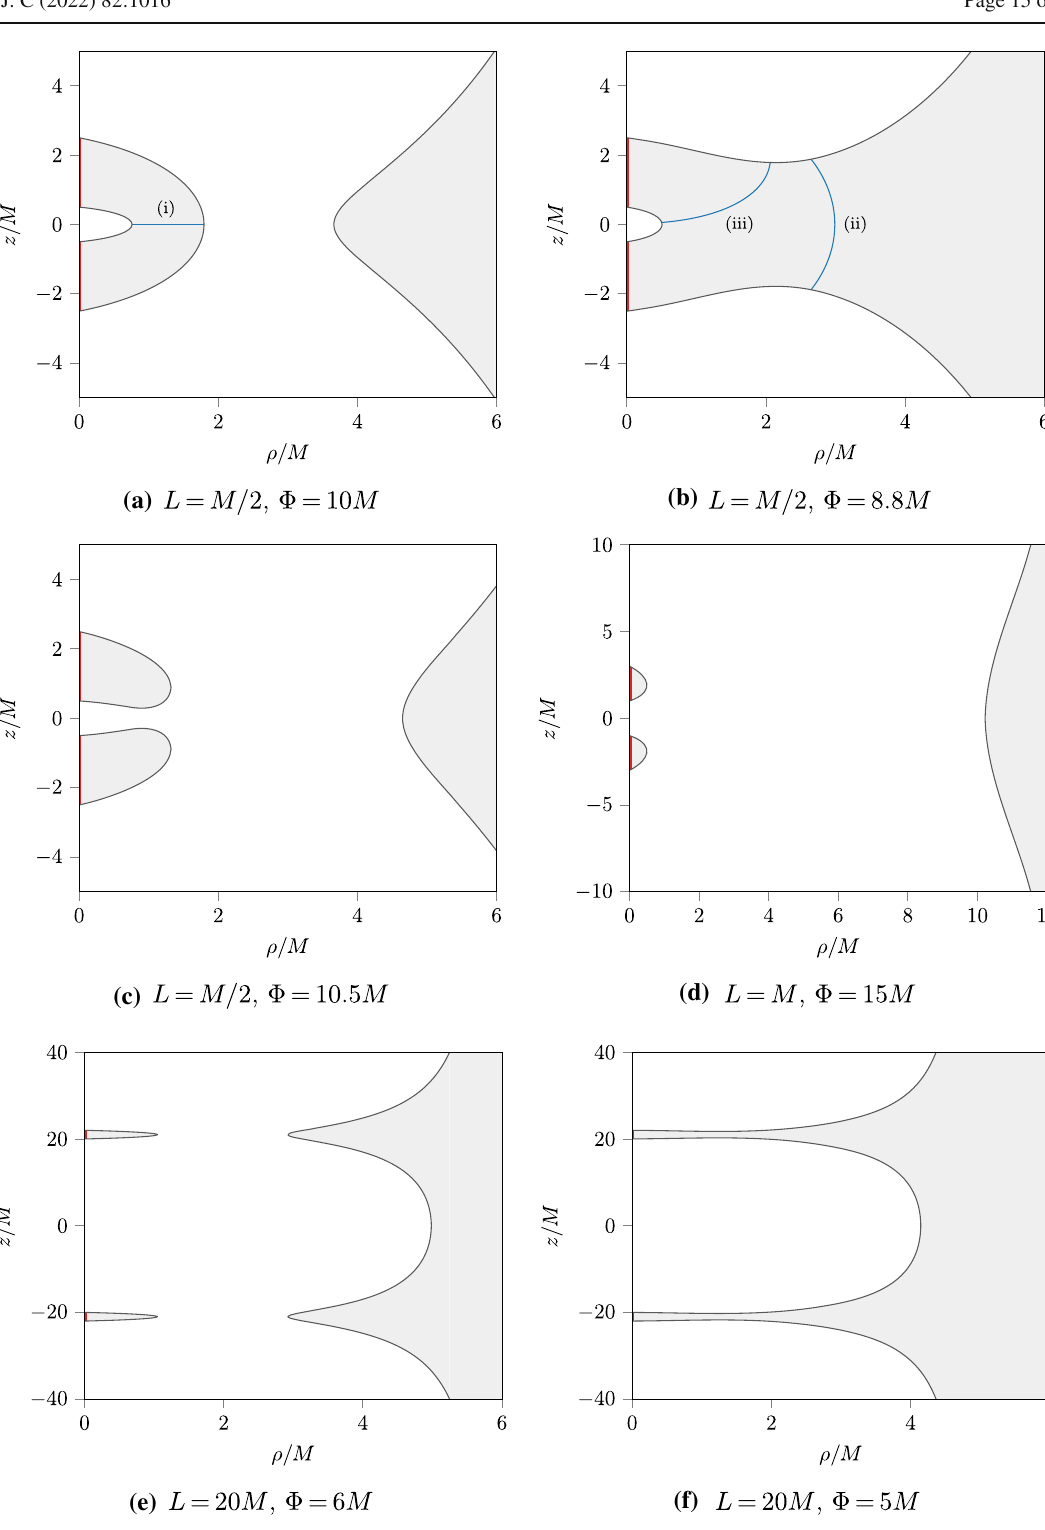
Fig. 13 Level curves of H (ρ, z ) for various choices of parameters. The grey regions indicate the regions of the (ρ, z ) plane where null geodesics are allowed to exist. In a and b , we have also plotted out three actual FPOs (blue curves), labelled by (i), (ii) and